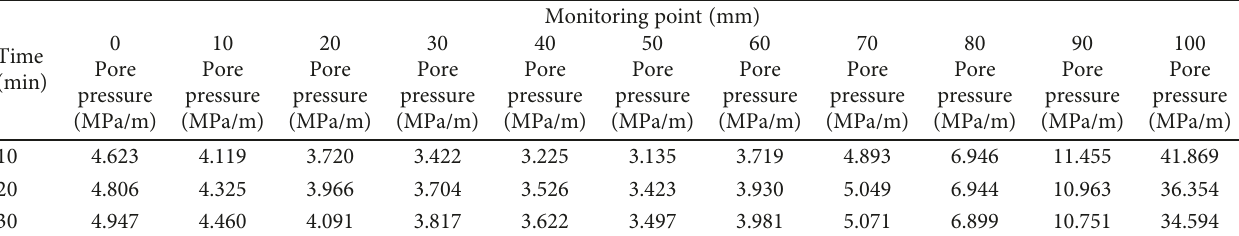
Figure 13: Space-time distribution of the pore pressure gradient along the driving direction. Table 4: Space-time distribution of the pore pressure gradient at the axial monitoring